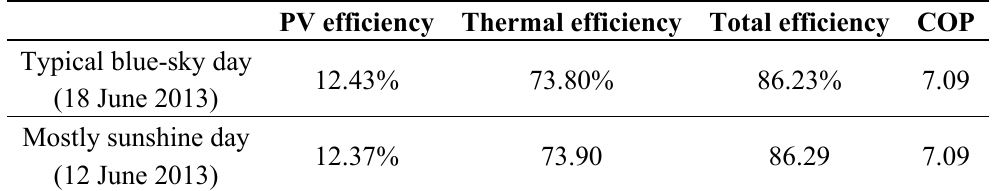
Table 7. Mean analysis of efficiency and performance for both a typical sunny day (18 June 2013) and a mostly sunny day (12 June